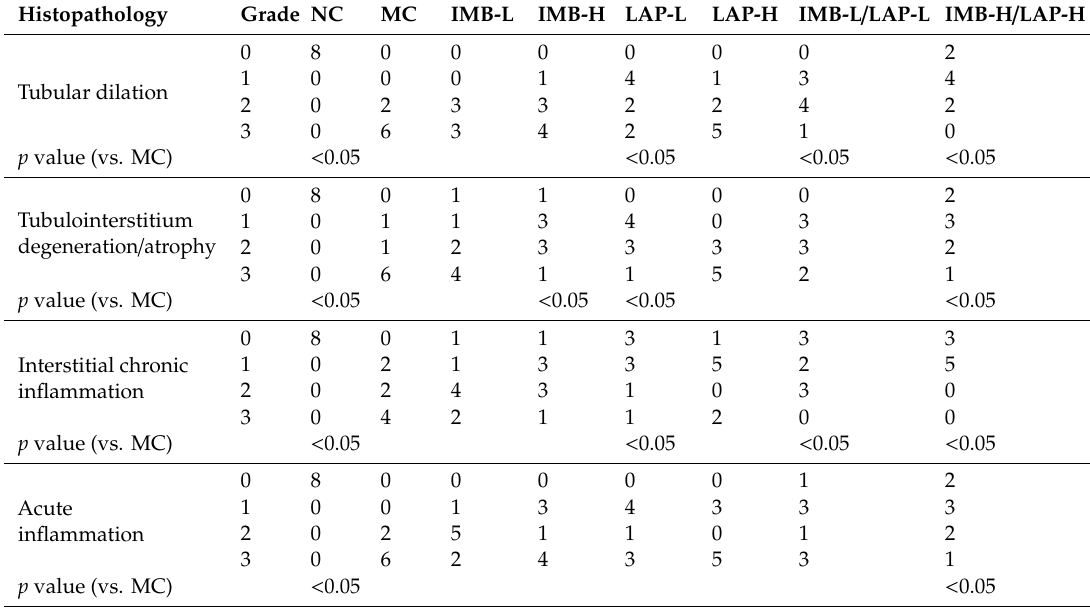
Table 2. Statistical Analysis Results of Histopathology Scores in